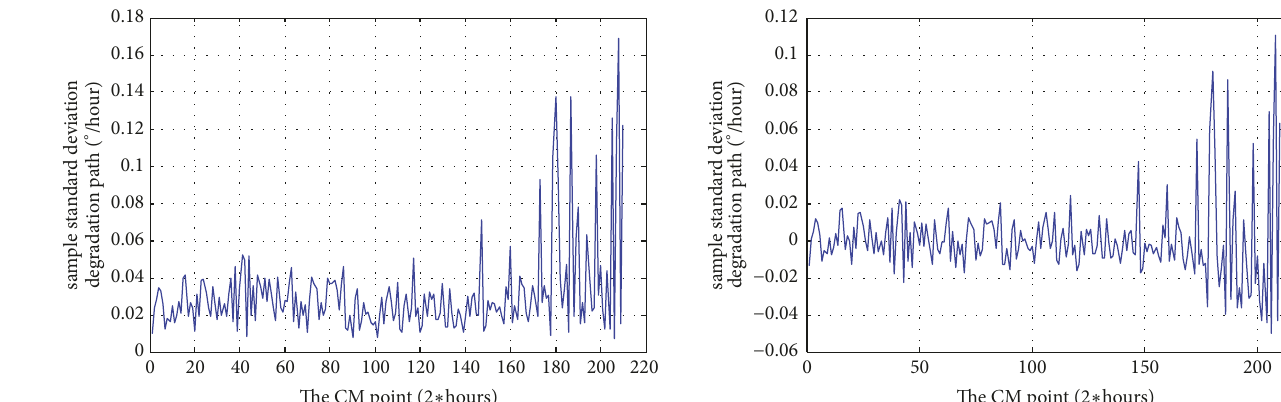
Figure 5: The sample standard deviation of the gyro drift.